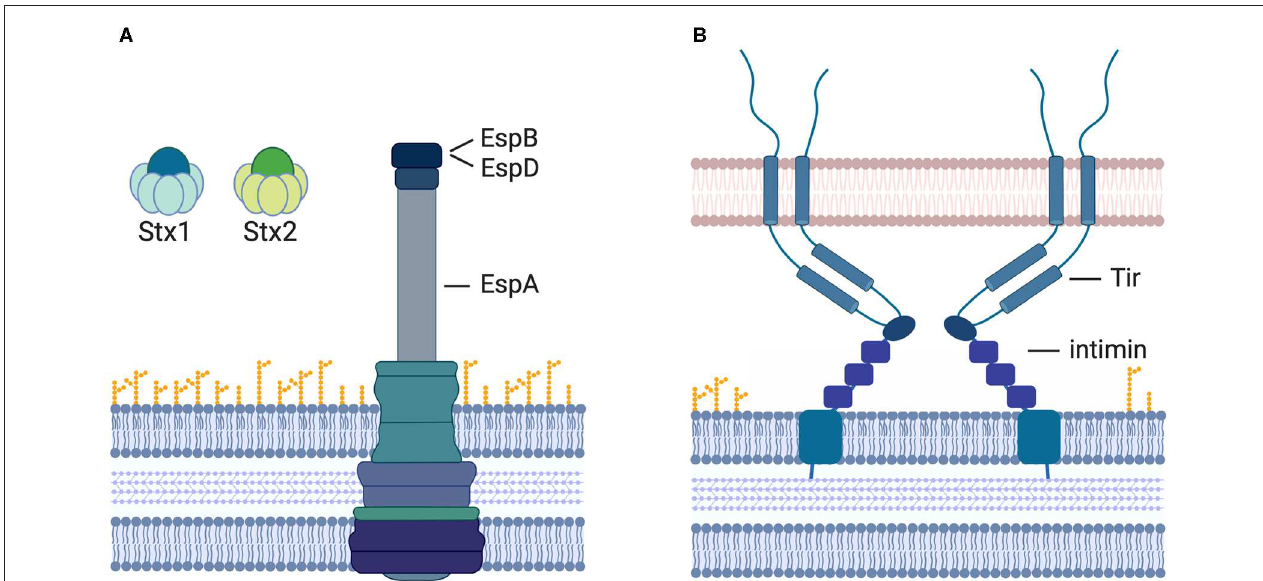
FIGURE 2 | Vaccination strategies to prevent STEC-induced diseases. Currently assessed vaccine targets include (A) the A-and B-subunits of Stx1 and Stx2, the T3SS components EspA (sheath) and EspB (pore complex), as well as (B) the bacterial outer membrane protein intimin and its T3-translocated receptor